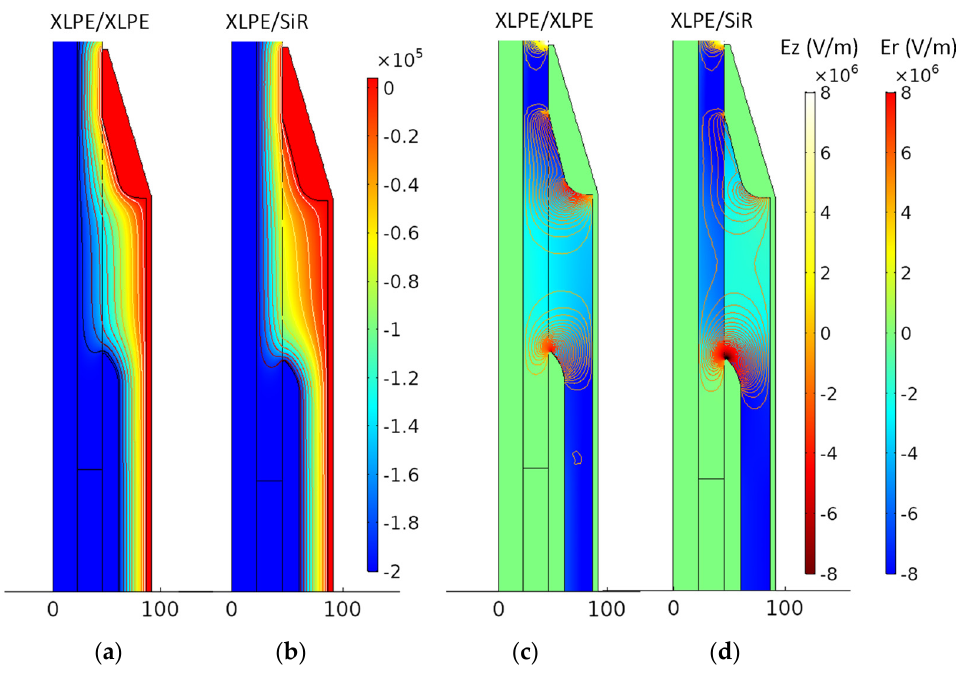
Figure 13. Potential distribution after 24 h under − 200 kV for ( a ) XLPE/XLPE and ( b ) XLPE/SiR joints. Corresponding radial (surface) and tangential (contour lines) field distributions for ( c ) XLPE/XLPE and ( d ) XLPE/SiR joints.